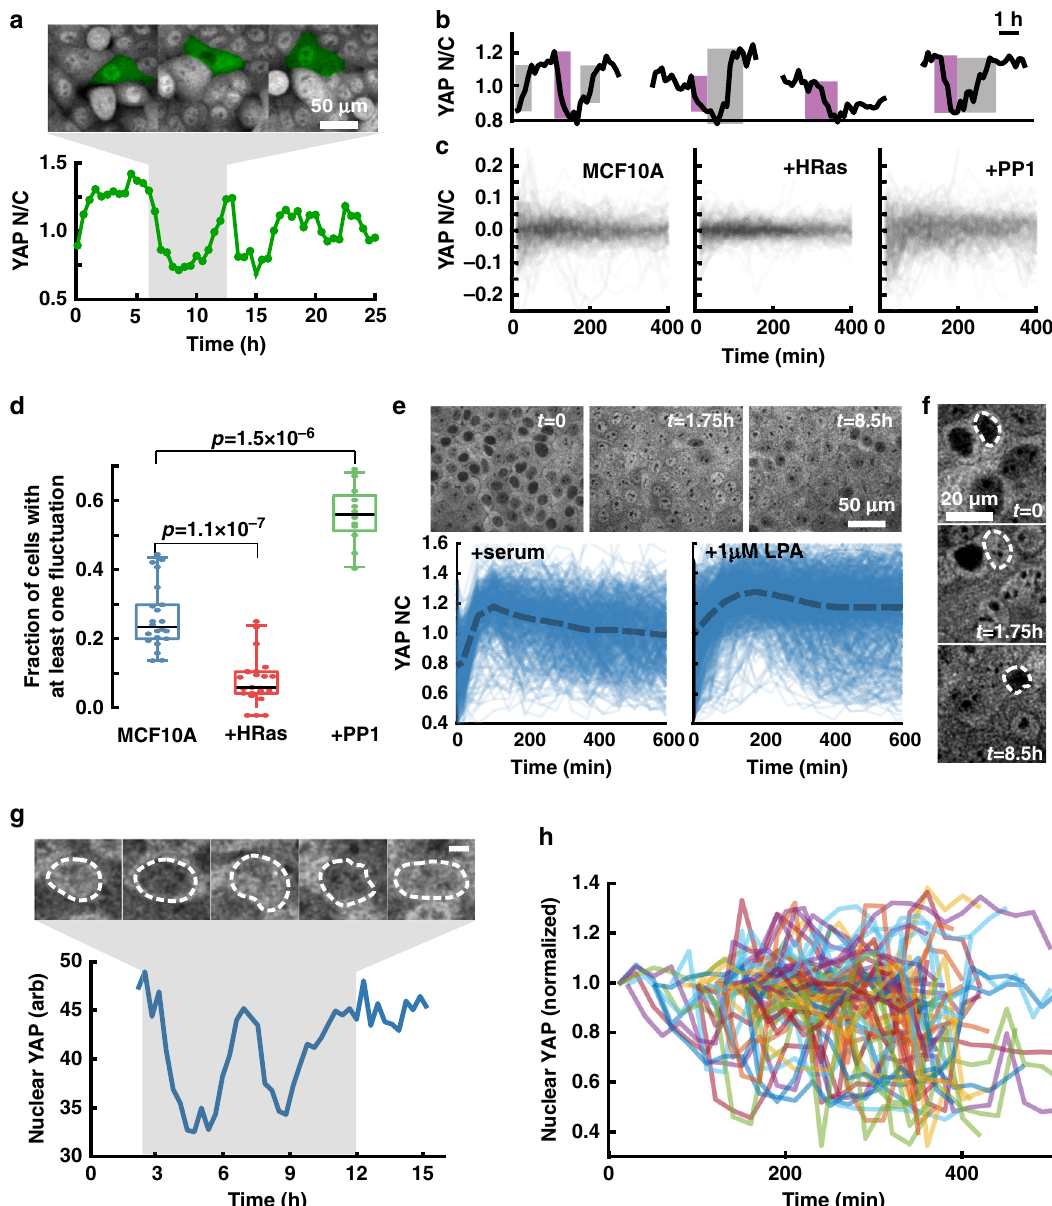
Fig. 3 Baseline (minute-scale) fl uctuations in YAP localization. a N / C trace of an individual MCF10A cell in monolayer and corresponding fl uorescence image (cell of interest is false colored in green). b Example traces of YAP N / C over time with large changes in signal highlighted by gray (increase) and purple (decrease) in MCF10A cells. c Overlay of YAP N / C traces for MCF10A, MCF10A + HRas, and MCF10A + 1 μ M PP1. Each plot contains 200